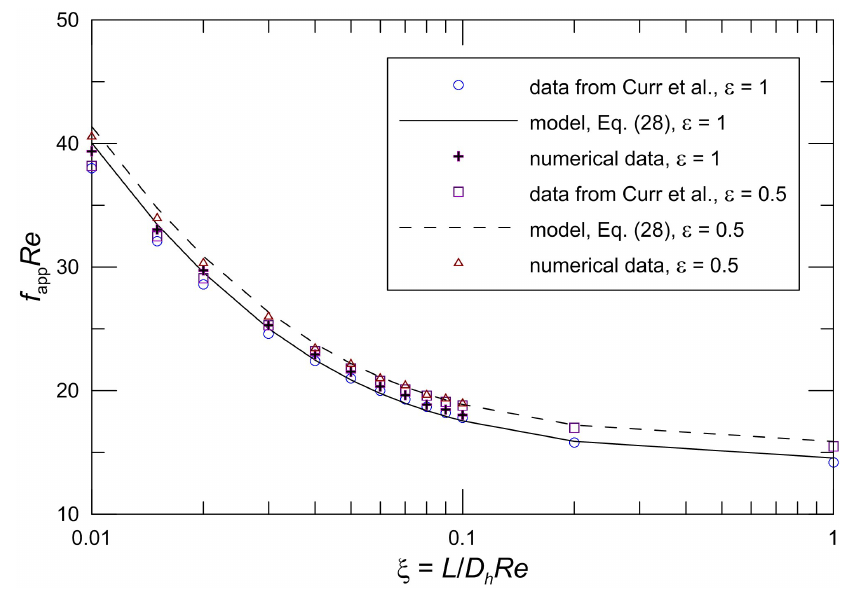
Figure 5 . Comparison of f app Re for Curr et al. [59] and new numerical data.